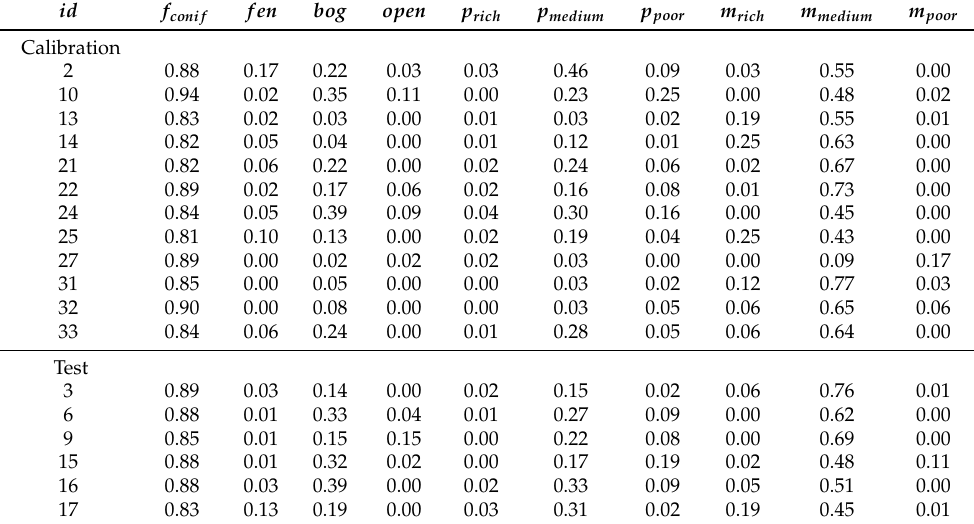
Table A1. Volume fraction of coniferous trees ( f conif ), areal share of fens, bogs and open peatlands ( fen , bog , open ), and peatlands in different fertility classes ( p rich , p medium , p poor ), and upland mineral soil sites in different fertility classes ( m rich , m medium , m poor ) in the